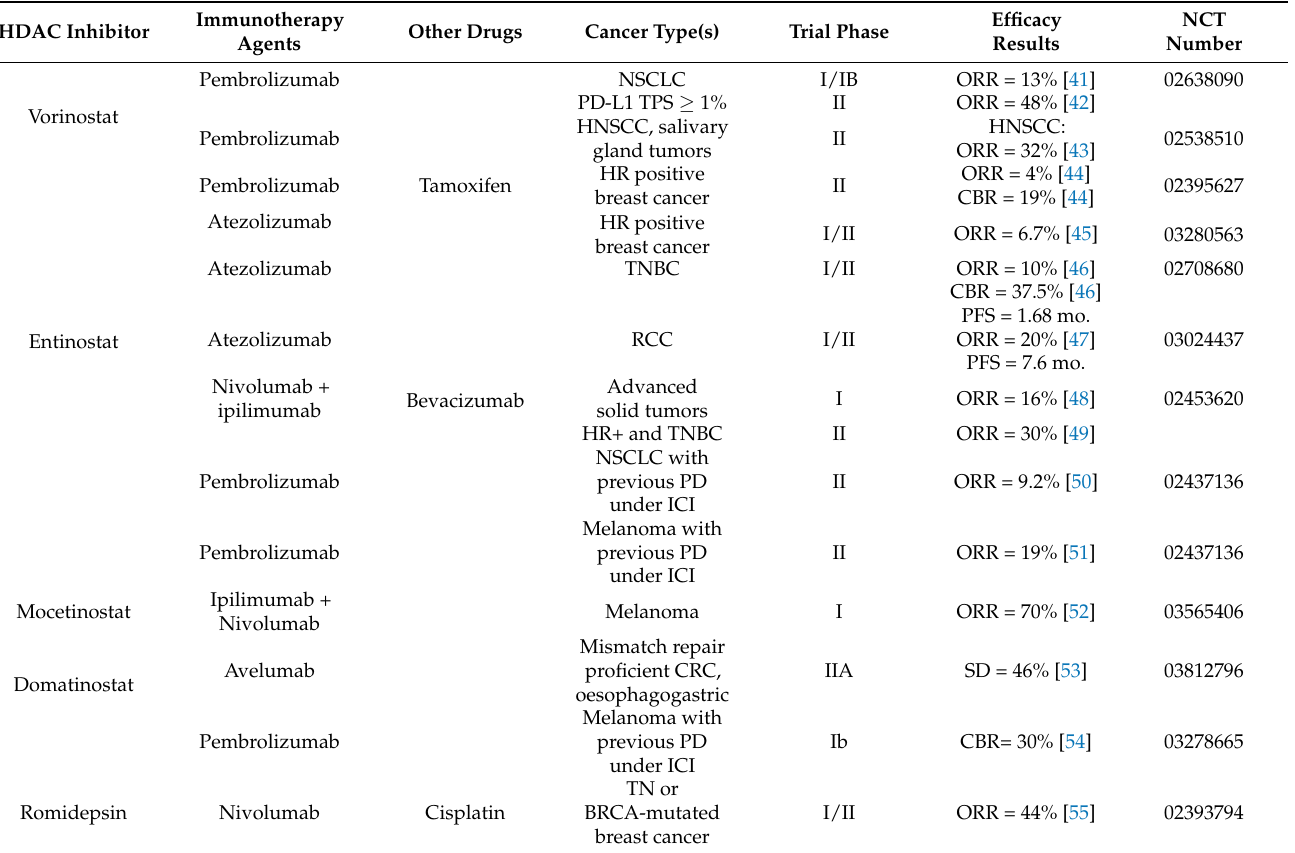
Table 1. Overview of clinical trials evaluating the combinations of HDAC inhibitors with immune checkpoint inhibitors in advanced solid